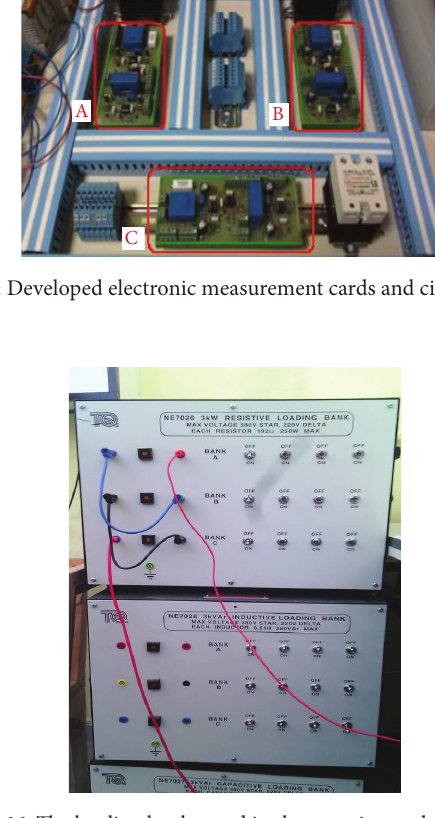
Figure 16: The loading banks used in the experimental test